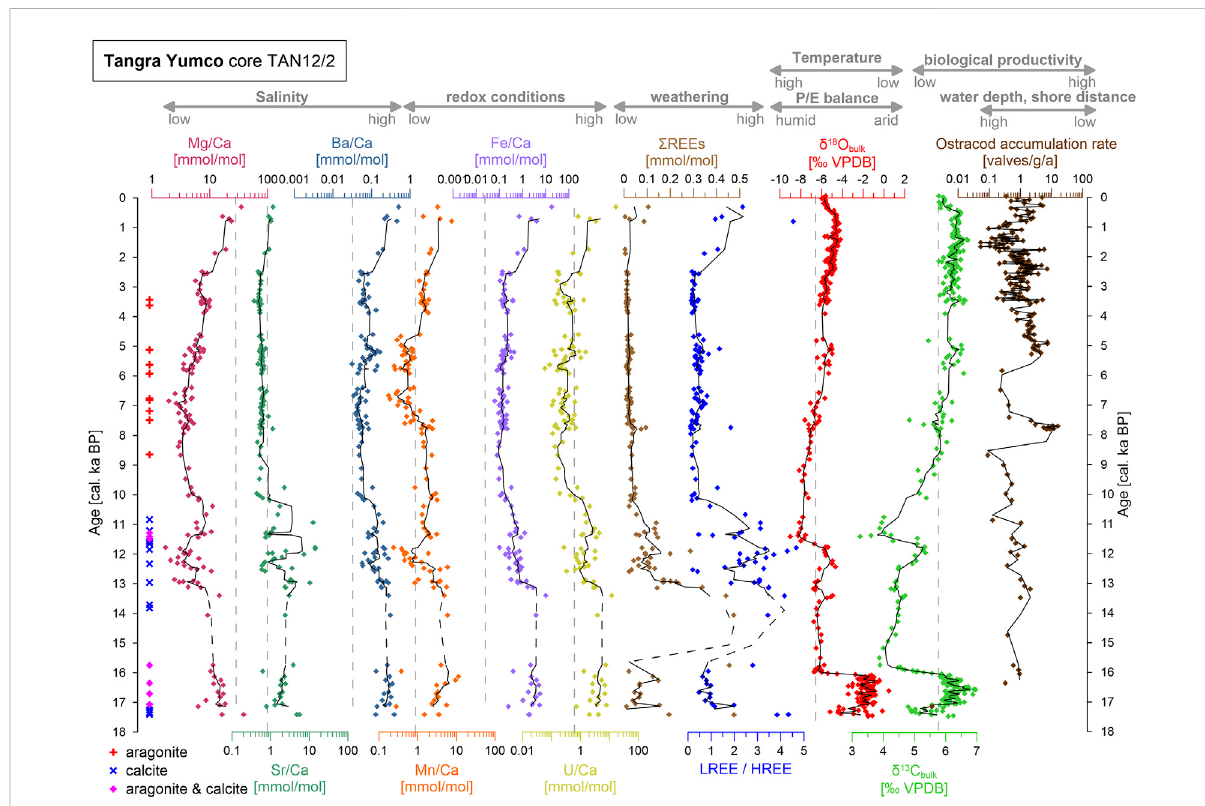
FIGURE 3 Tangra Yumco traceelementand REE record ofostracodshells and stable isotopes of bulk sediment( δ 18 O bulk and δ 13 C bulk )from core TAN12-2. Authigenic carbonate mineralogy is shown on the left to indicate phases of formation of aragonite (red cross), calcite (blue x), and combination of calciteandaragonite(purplediamond).DashedlinesshowlevelsofmodernvaluesfromBörneretal.(2017).Solidblacklinesshow5-pointsmoothed data. See caption of Figure 2 for more